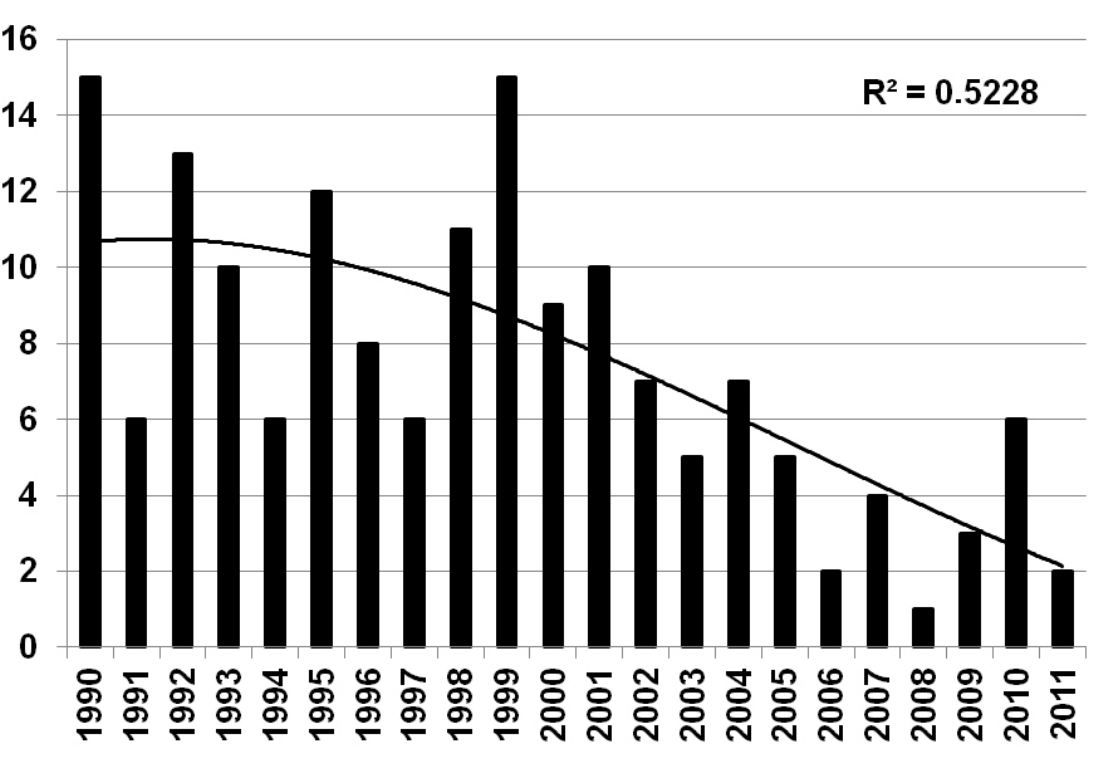
Figure 1. Trend in mortality from scorpion stings in the province of